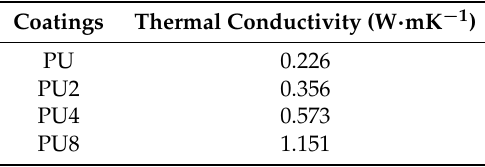
Table 1. Thermal conductivity of PU coating and PU/Gr composite